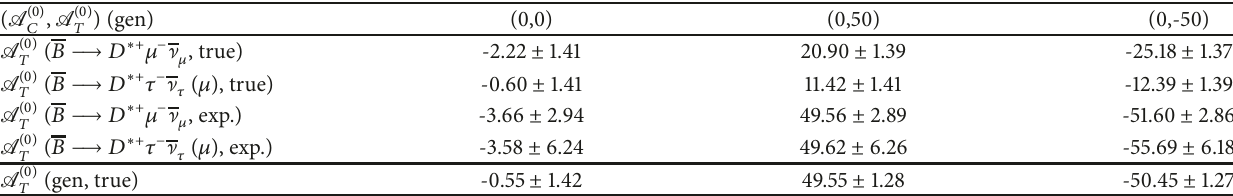
Table 2: Measured A (0) 𝑇 (in %) fitting the angular distribution equation (19) or the polynomial expansions equation (20) to the 𝐵 󳨀→ 𝐷 ∗+ 𝑙 − ] 𝑙 test samples for varying generated values; the last row reports the ideal sensitivity obtained from a toy sample generated from the true angular distribution with the same number of events of the test sample, fitted with the same distribution.